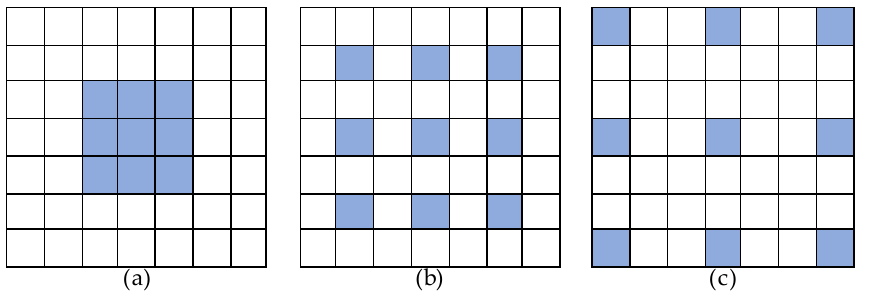
Figure 6. The dilated convolution with different dilation rates, representing the different receptive fields. ( a ) Rate = 1. ( b ) Rate = 2. ( c ) Rate =